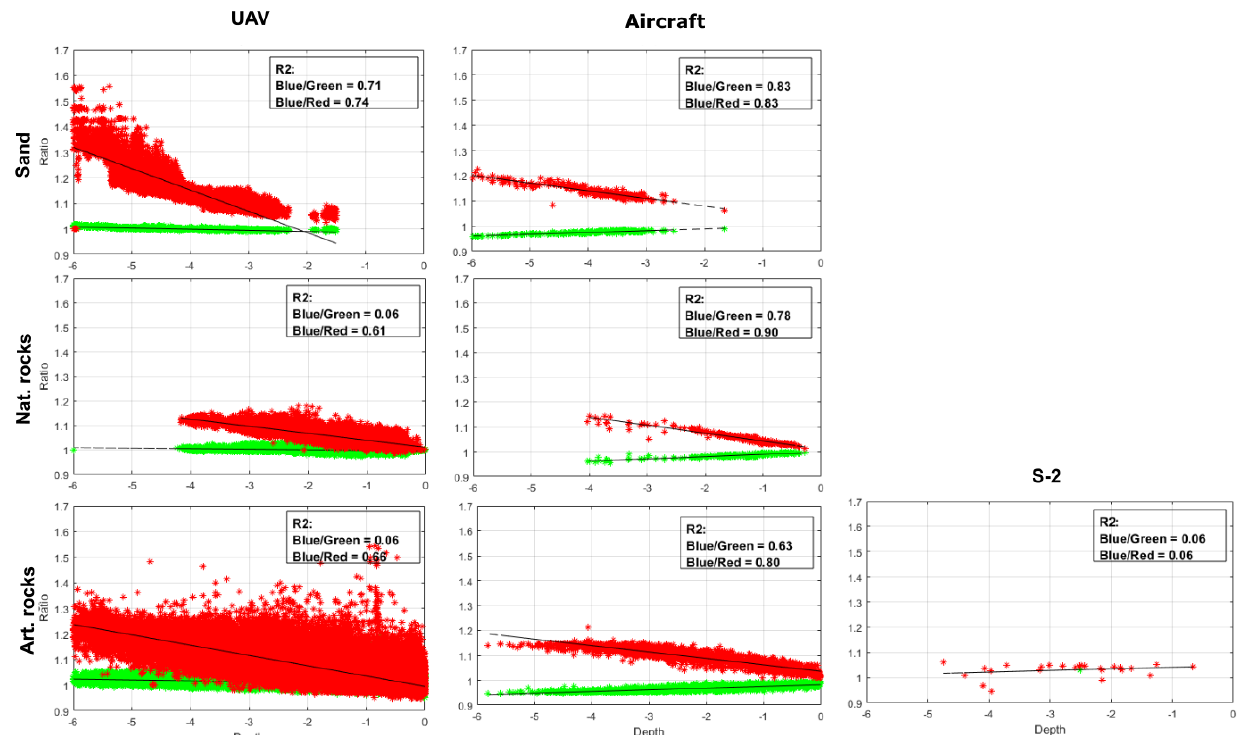
Figure 16. Calibration results showing the relationship between the blue/green ratio (represented with green dots) or the blue/red ratio (represented with red dots) and the depth of the calibration points sets for UAV and aircraft orthophotos within the three considered classes, i.e., sand, natural and artificial rocks, and the S-2 orthophoto for artificial rocks. The R 2 values of each regression are reported in the legend of each plot. Portosole overlap